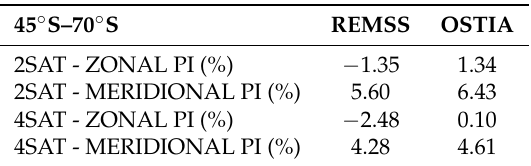
Table 1. REMSS and OSTIA PI in the 45 ◦ S to 70 ◦ S latitudinal band. The results are given for the two flow